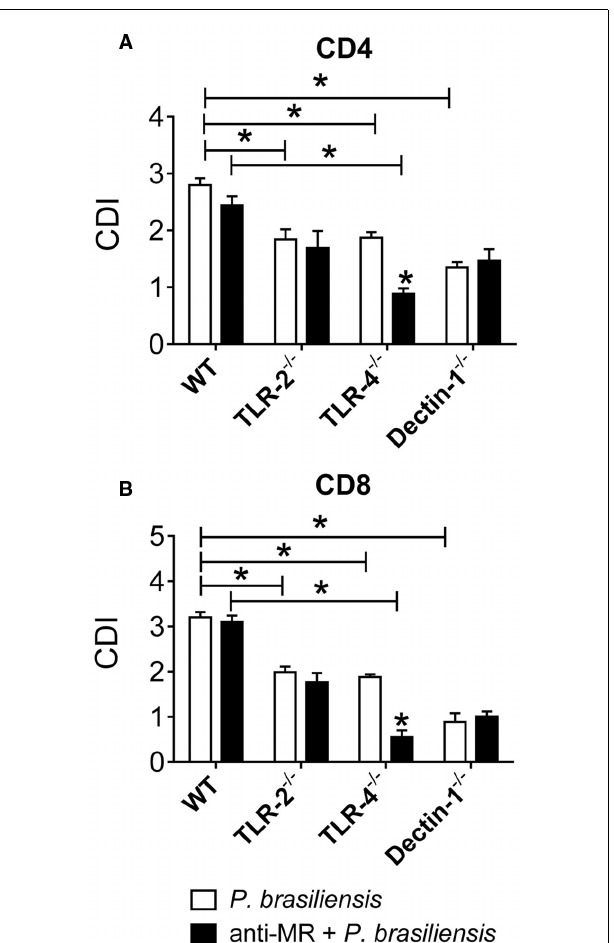
FIGURE 7 | MR collaborates with TLR-4 in the induction of T cell proliferation. BMDCs from WT, TLR-2 (cid:0) / (cid:0) , TLR-4 (cid:0) / (cid:0) , and Dectin-1 (cid:0) / (cid:0) mice were cultured and then treated or not with anti-MR antibody for 30 min and infected with viable P. brasiliensis yeasts for 2 h. Splenic lymphocytes from uninfected WT, TLR-2 (cid:0) / (cid:0) , TLR-4 (cid:0) / (cid:0) , and Dectin-1 (cid:0) / (cid:0) mice were previously labeled with CFSE (5 mM) and co-cultivated with anti-MR treated or untreated DCs. After 5 days, the cells were adjusted to 1 (cid:2) 10 6 , labeled with specific anti-CD4 (A) and CD8 (B) antibodies and analyzed by flow cytometry. The lymphocyte population was gated by FSC/SSC analysis. The results are expressed as frequency of positive cells. Data are means (cid:6) SD of five wells per group from three independent experiments (* P <